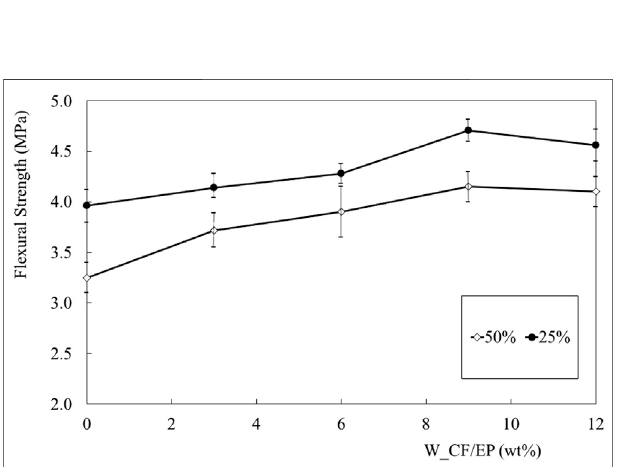
FIGURE 6 | Flexural strength of the investigated materials.